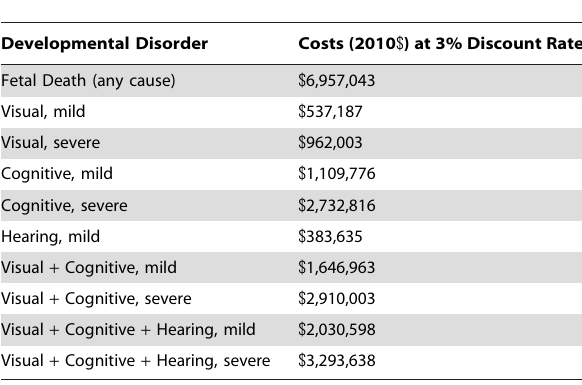
Table 2. Cost estimates for outcomes of congenital toxoplasmosis (RTI estimates adjusted to 2010 $ ).